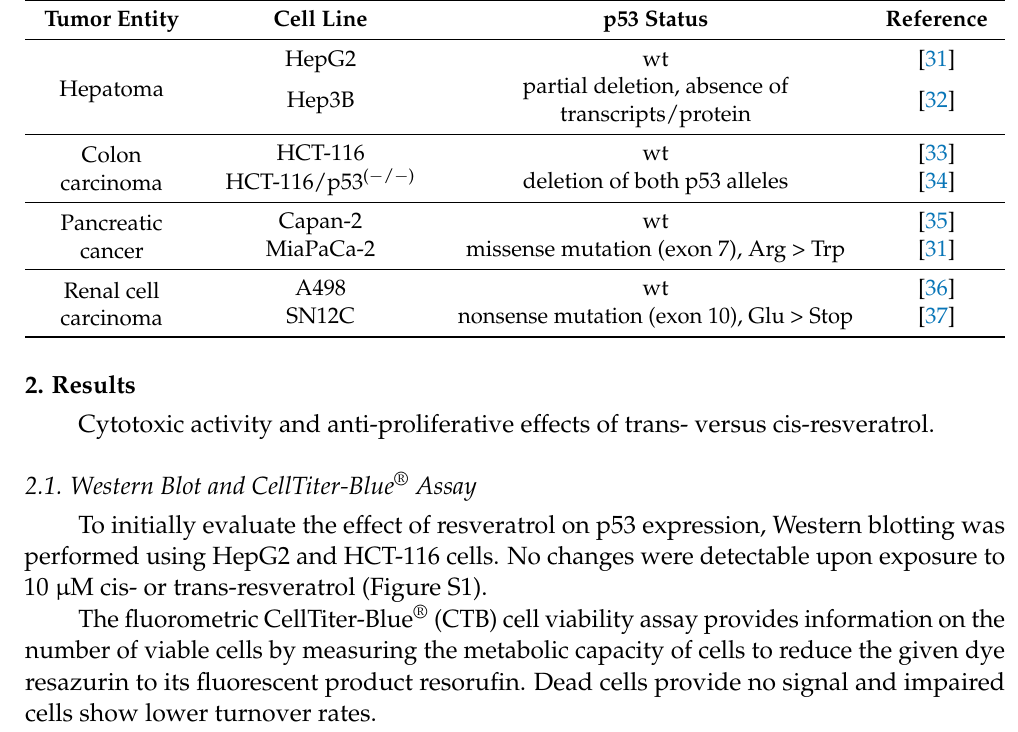
Table 1. Tumor entities and p53 status of tumor cell lines employed throughout this